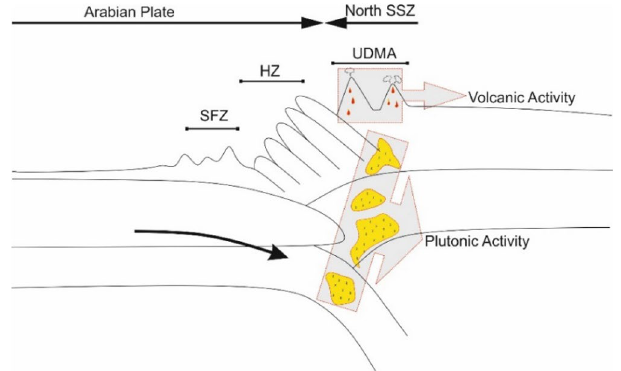
Figure 2. Tectonic evolution of the North Sanandaj–Sirjan Zone (NSSZ) during Middle Eocene (adopted from 38 ). HZ and SFZ stand for High Zagros and Simply Folded Zagros, respectively.